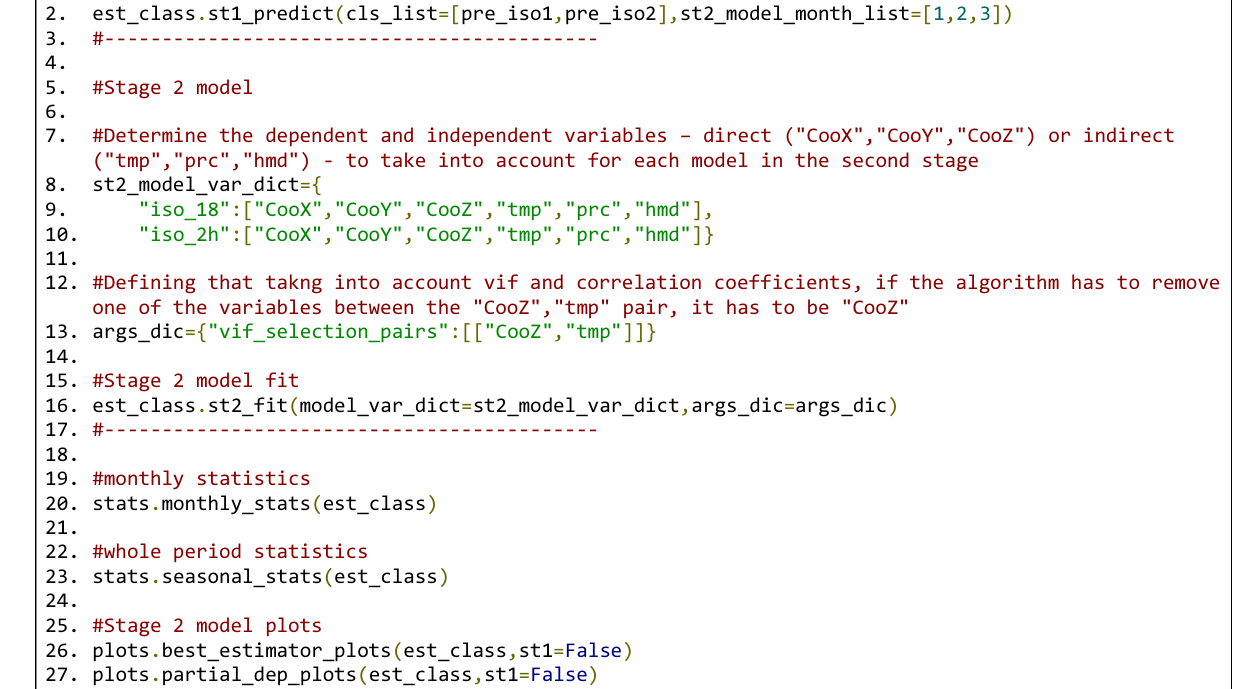
Figure 12. Stage-one estimation calculations (line 2). Stage-two model argument definitions (lines 7–10). Stage-two model execution (line 16). Statistical reports and plots (lines 26–27).